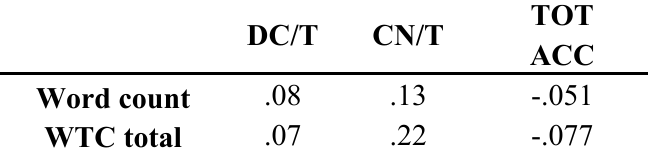
Correlations among Michelle’s topic measures and total complexity and accuracy